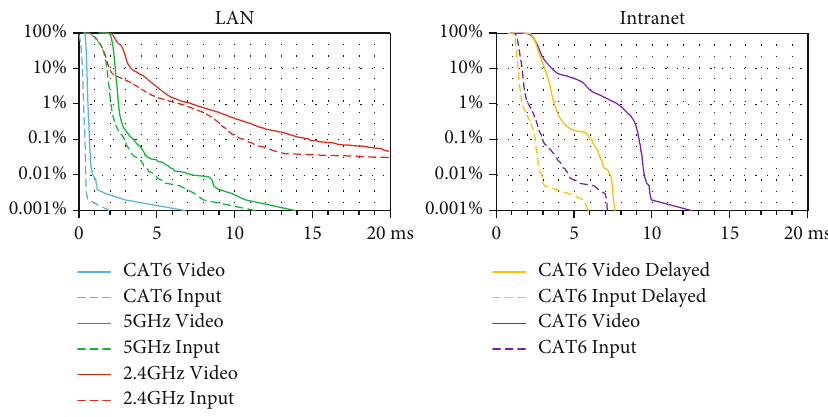
Figure 5: CCDF of network component time consumption in LAN. Each curve is based on 100000 samples. Table 3: Soak test statistics (V: video; I: